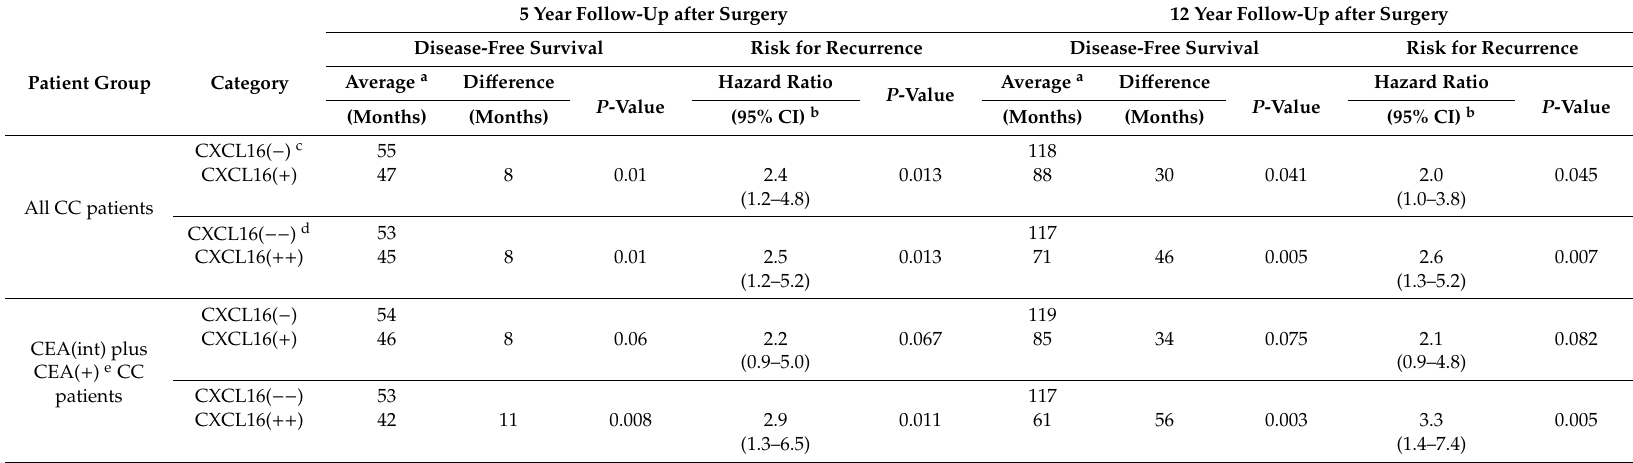
Table 1. Comparative analysis of average survival time after surgery and risk for recurrence of disease in CC patients with CXCL16( − ) and CXCL16( + ), and CXCL16( −− ) and CXCL16( ++ ) lymph